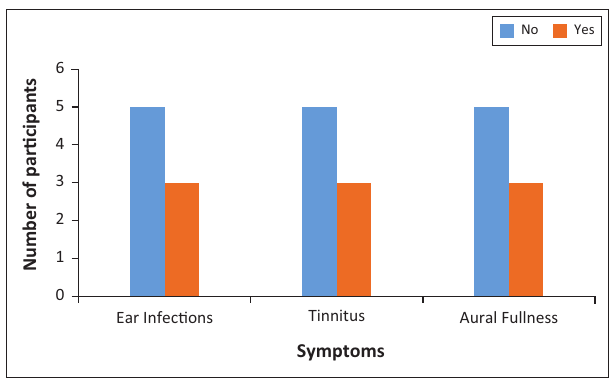
FIGURE 1: Study participants’